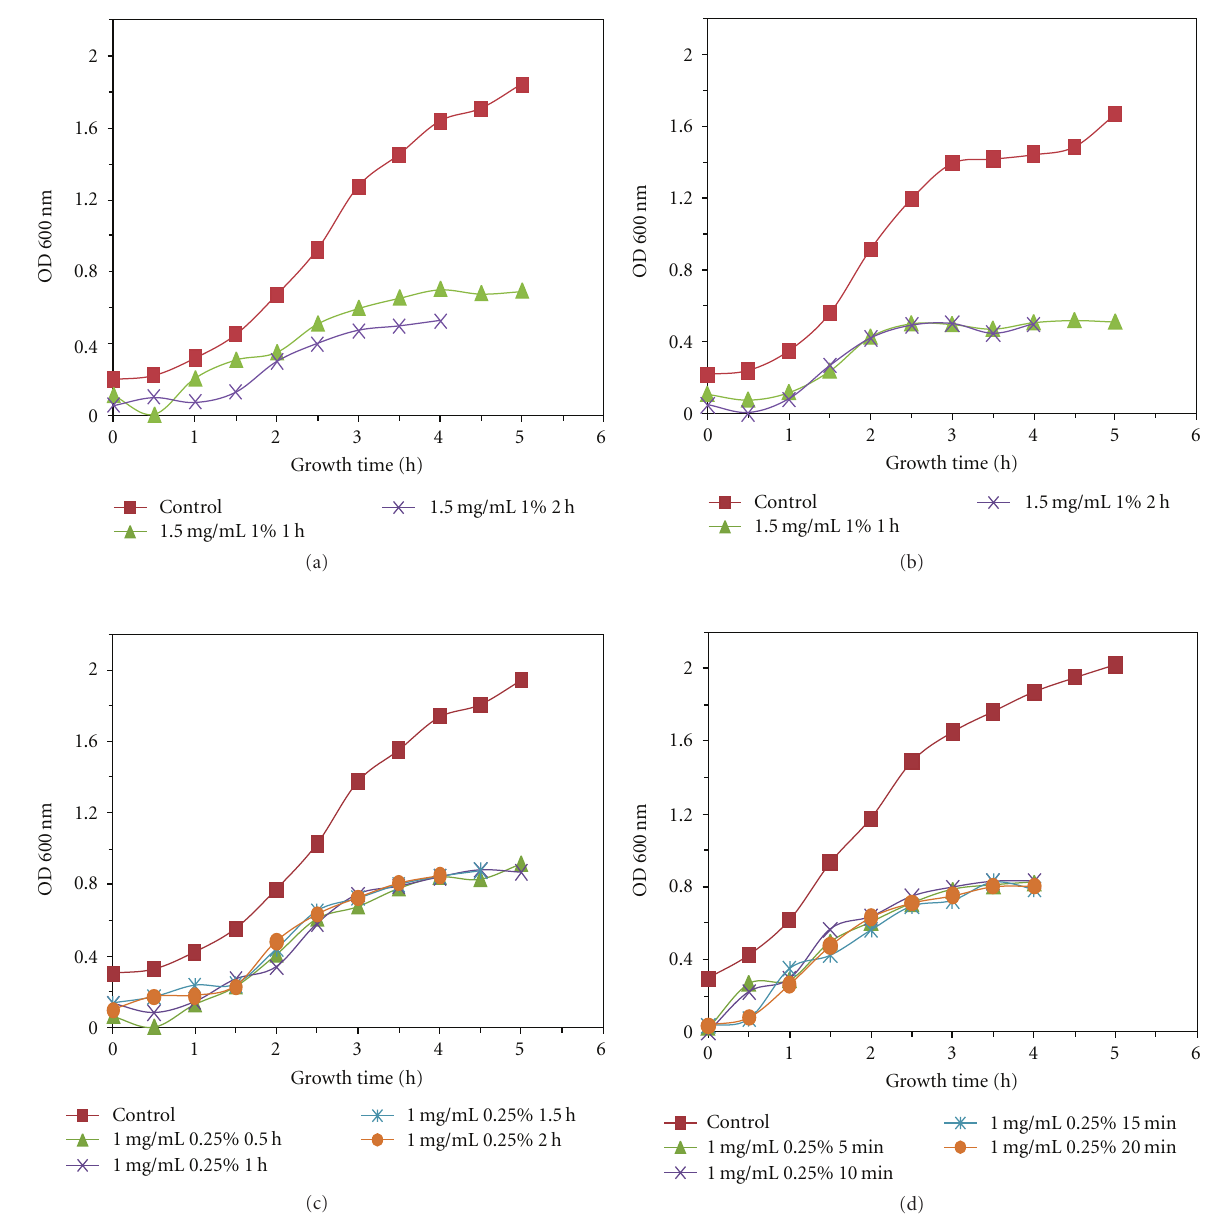
Figure 5: OD growth curves of bacterial cells after treatment with SWCNT + surfactant solutions. The legend shows SWCNT concentration in mg/mL, SC surfactant concentrations in %, and incubation times in h or min: (a) S. enterica and (b) E. coli treated with 1.5mg/mL and 1% for 1h and 2h, (c) S. enterica treated with 1mg/mL and 0.25% for 0.5h, 1h, 1.5 h, and 2h, and (d) S. enterica treated with 1mg/mL and 0.25% for 5min, 10min, 15 min, and 20 min. Nanotube blanks were created as in Figure 4. Other conditions are the same as in Figure